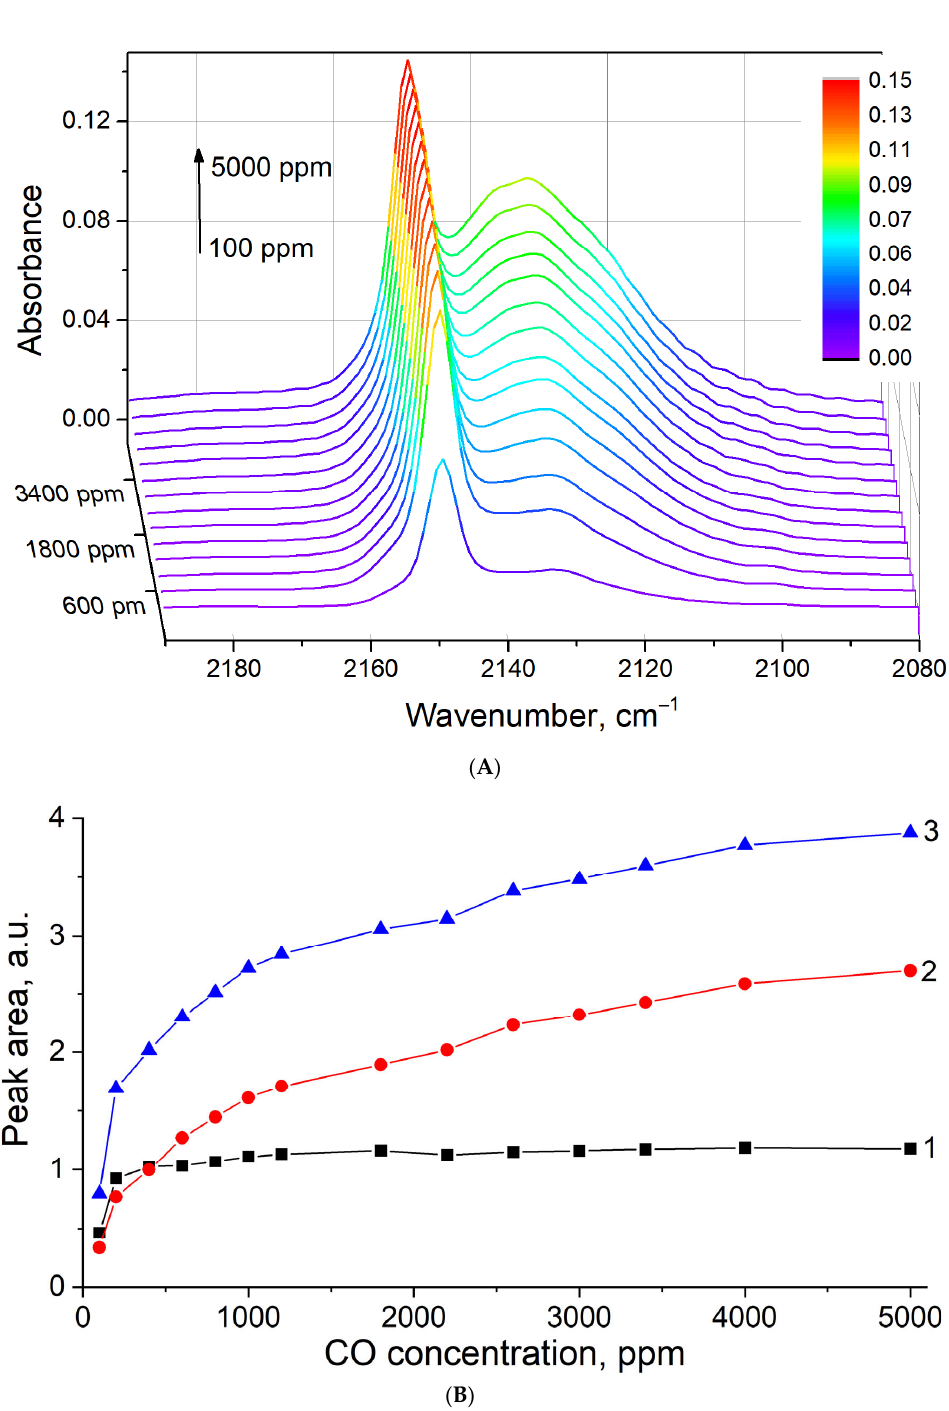
Figure 9. ( A ) Difference FTIR spectra of CO adsorbed on CuSn-BEA; 100–5000 ppm (in Ar flow containing 100 ppm of water vapour). ( B ) Evolution of the total peak area of CO adsorbed on CuSn-BEA; 100–5000 ppm; 2149 cm − 1 peak (1), 2132 cm − 1 peak (2) and total peak area